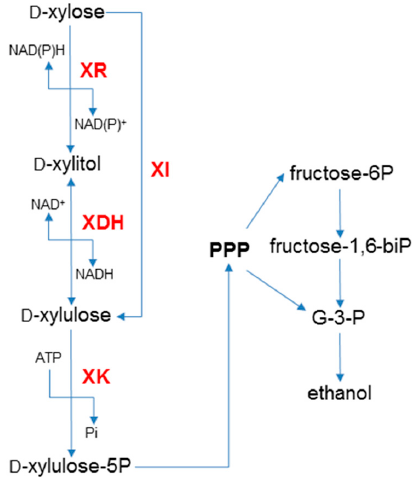
Figure 1. Xylose fermentation in S. cerevisiae . The fungal pathway uses xylose reductase (XR) and xylitol dehydrogenase (XDH,) whereas the bacterial pathway uses xylose isomerase (XI). Both pathways produce D -xylulose which is converted to D -xylulose-5P by endogenous xylulokinase (XK). D -Xylulose-5P then enters the pentose phosphate pathway (PPP) where it is further metabolized to form ethanol under appropriate conditions. Arrows indicate the direction of the chemical reactions.